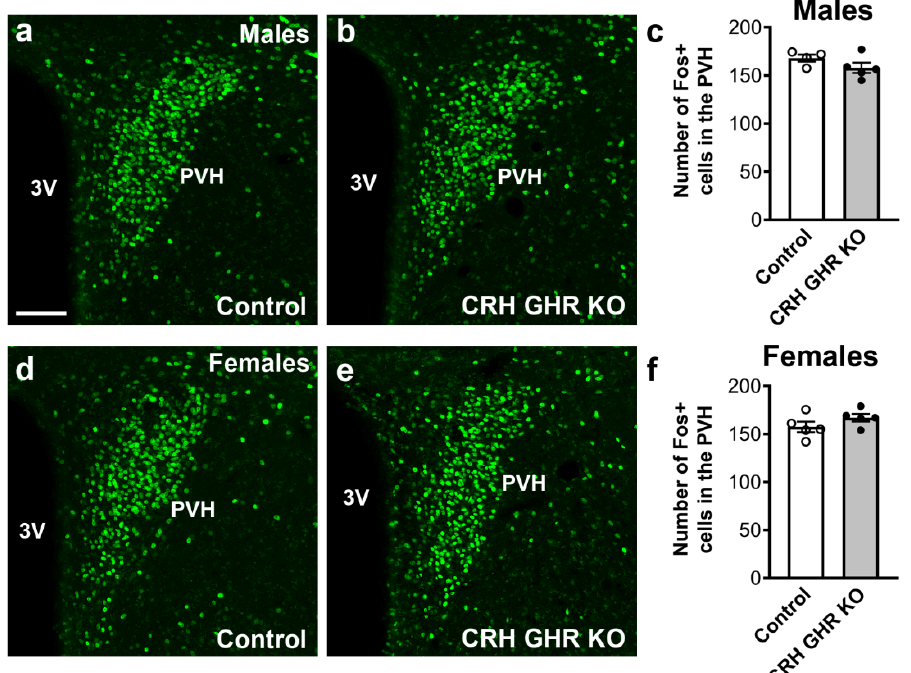
Figure 6. CRH GHR KO mice exhibit normal activation of PVH neurons after restraint stress. ( a – c ) Restraint-stress induced Fos expression in the PVH of control (white circles; n = 4) and CRH GHR KO (black circles; n = 5) male mice. ( d – f ) Restraint-stress induced Fos expression in the PVH of control ( n = 5) and CRH GHR KO ( n = 5) female mice. Abbreviation: 3V, third ventricle. Scale bar = 100 µm.